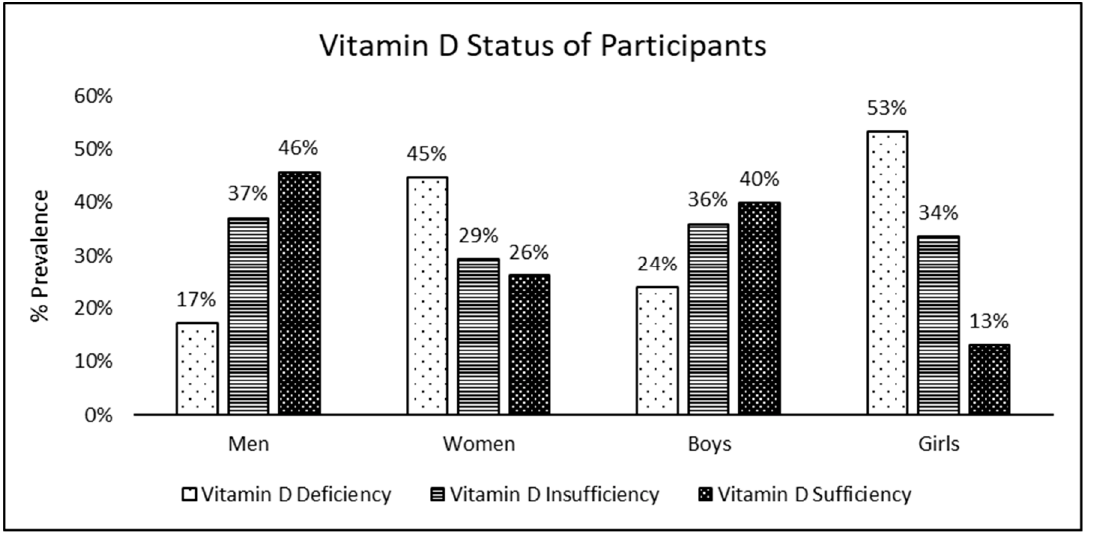
Figure 1. Vitamin D status of participants stratified by gender and age. The classification of vitamin D status into vitamin D deficiency, insufficiency, and sufficiency is based on the IOM guidelines [17].